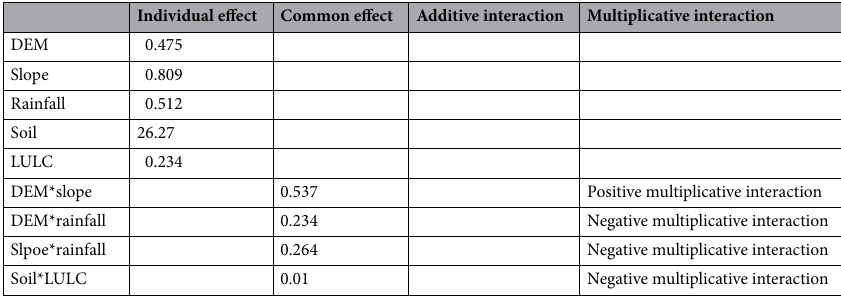
Table 6. Analysis of interaction